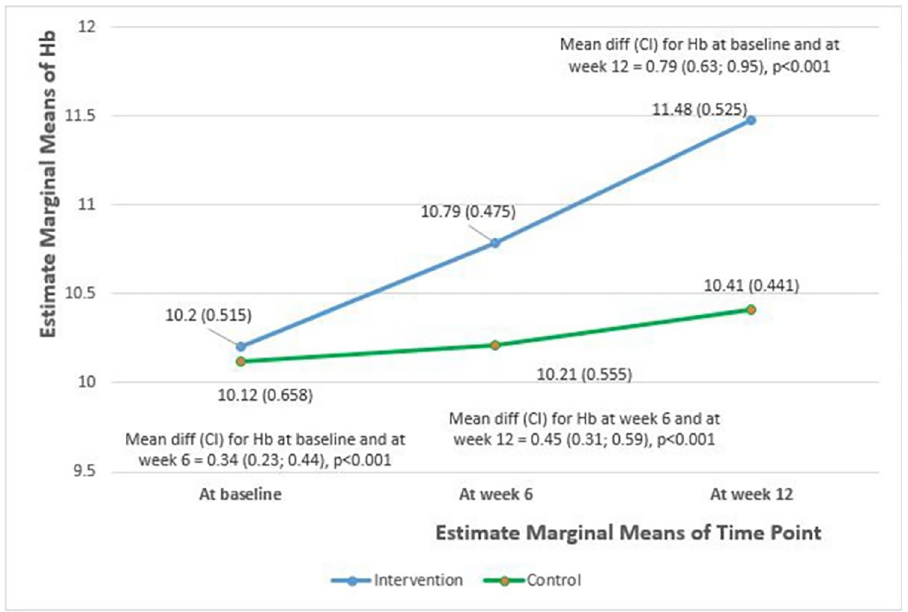
Fig 2. Changes of haemoglobin (Hb) over times between groups at baseline, week 6 and week 12 for intervention and control group.